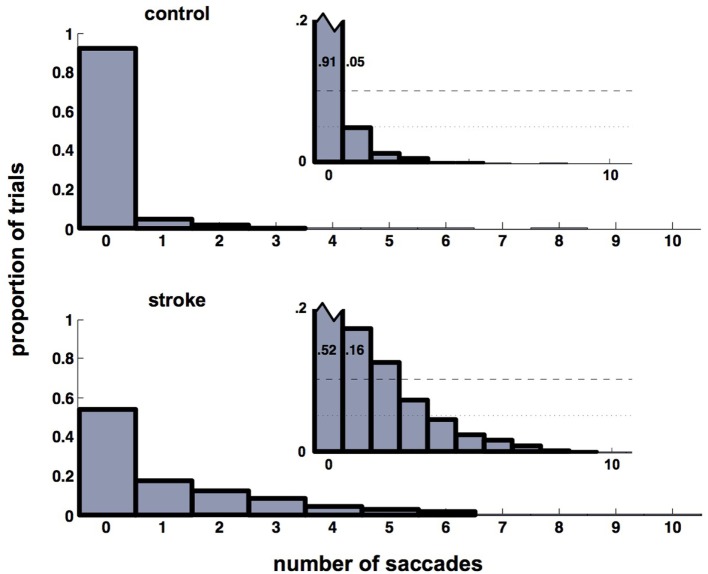
Histograms of the number of saccades in addition to the primary saccade. Control participants (upper histograms) overwhelmingly produce a primary saccade only (91% of trials). About 96% of trials contain either no additional saccades beyond the primary saccade, or contain a single secondary saccade (see inset). For stroke participants (lower histogram), the same 96% of trials contains up to five secondary saccades (see inset). Insets show the same histograms with re-scaled axes to highlight histogram heights for non-primary saccades. This re-scaling truncates the ordinate at p = 0.2, which allows the pattern in the smaller-height histogram bars (those corresponding to trials that included non-primary saccades) to be seen. Heights of the first two bars in each inset are labeled to help emphasize the re-scaling.